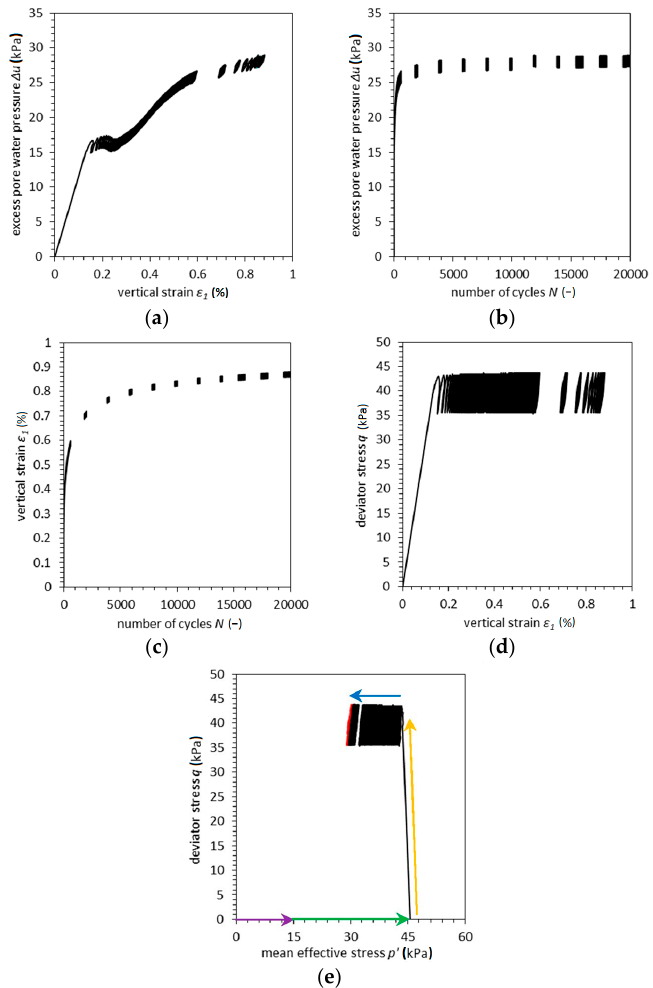
Figure 2. Results of the cyclic triaxial test for sandy silty clay under a confining pressure of 45 kPa and under the isotropic consolidation, initial void ratio e 0 = 0.414—sample 1.1: ( a ) Excess pore water pressure versus vertical strain characteristic, ( b ) excess pore water pressure characteristic versus number of cycles, ( c ) vertical strain characteristic versus number of cycles, ( d ) deviator stress–vertical strain relationship, and ( e ) the deviator stress–mean effective stress relationship (red color—last 10 cycles; arrow color—violet: Saturation phase, green: Consolidation phase, orange: First cycle of cyclic loading, blue: Cyclic loading program).